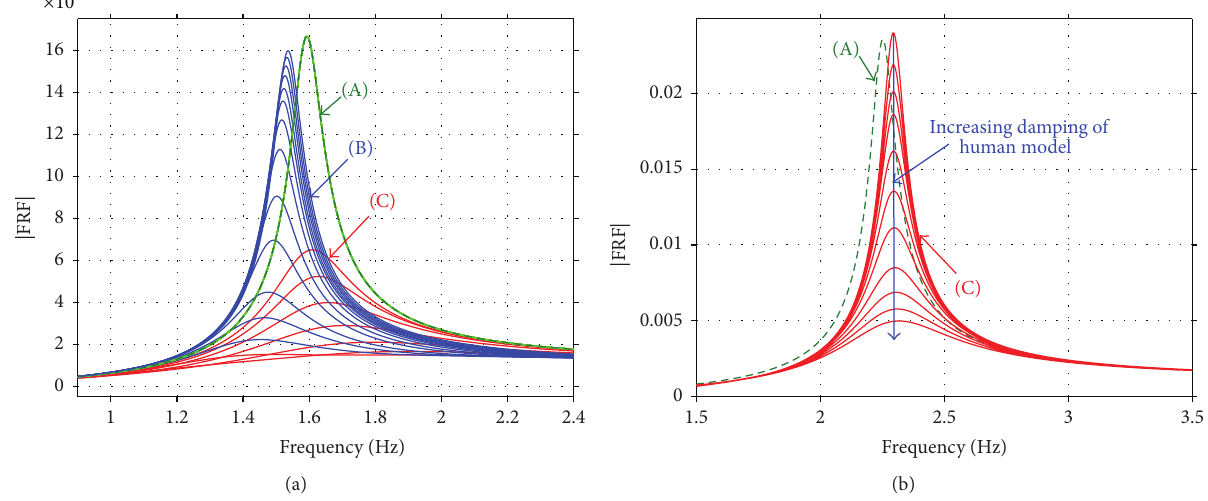
Figure 6: Effects of (a) walking human natural frequency and (b) damping ratio on structure FRF. (A) Empty structure; (B) 𝑓 ℎ > 𝑓 𝑠 ; (C) < 𝑓 𝑓 ℎ 𝑠